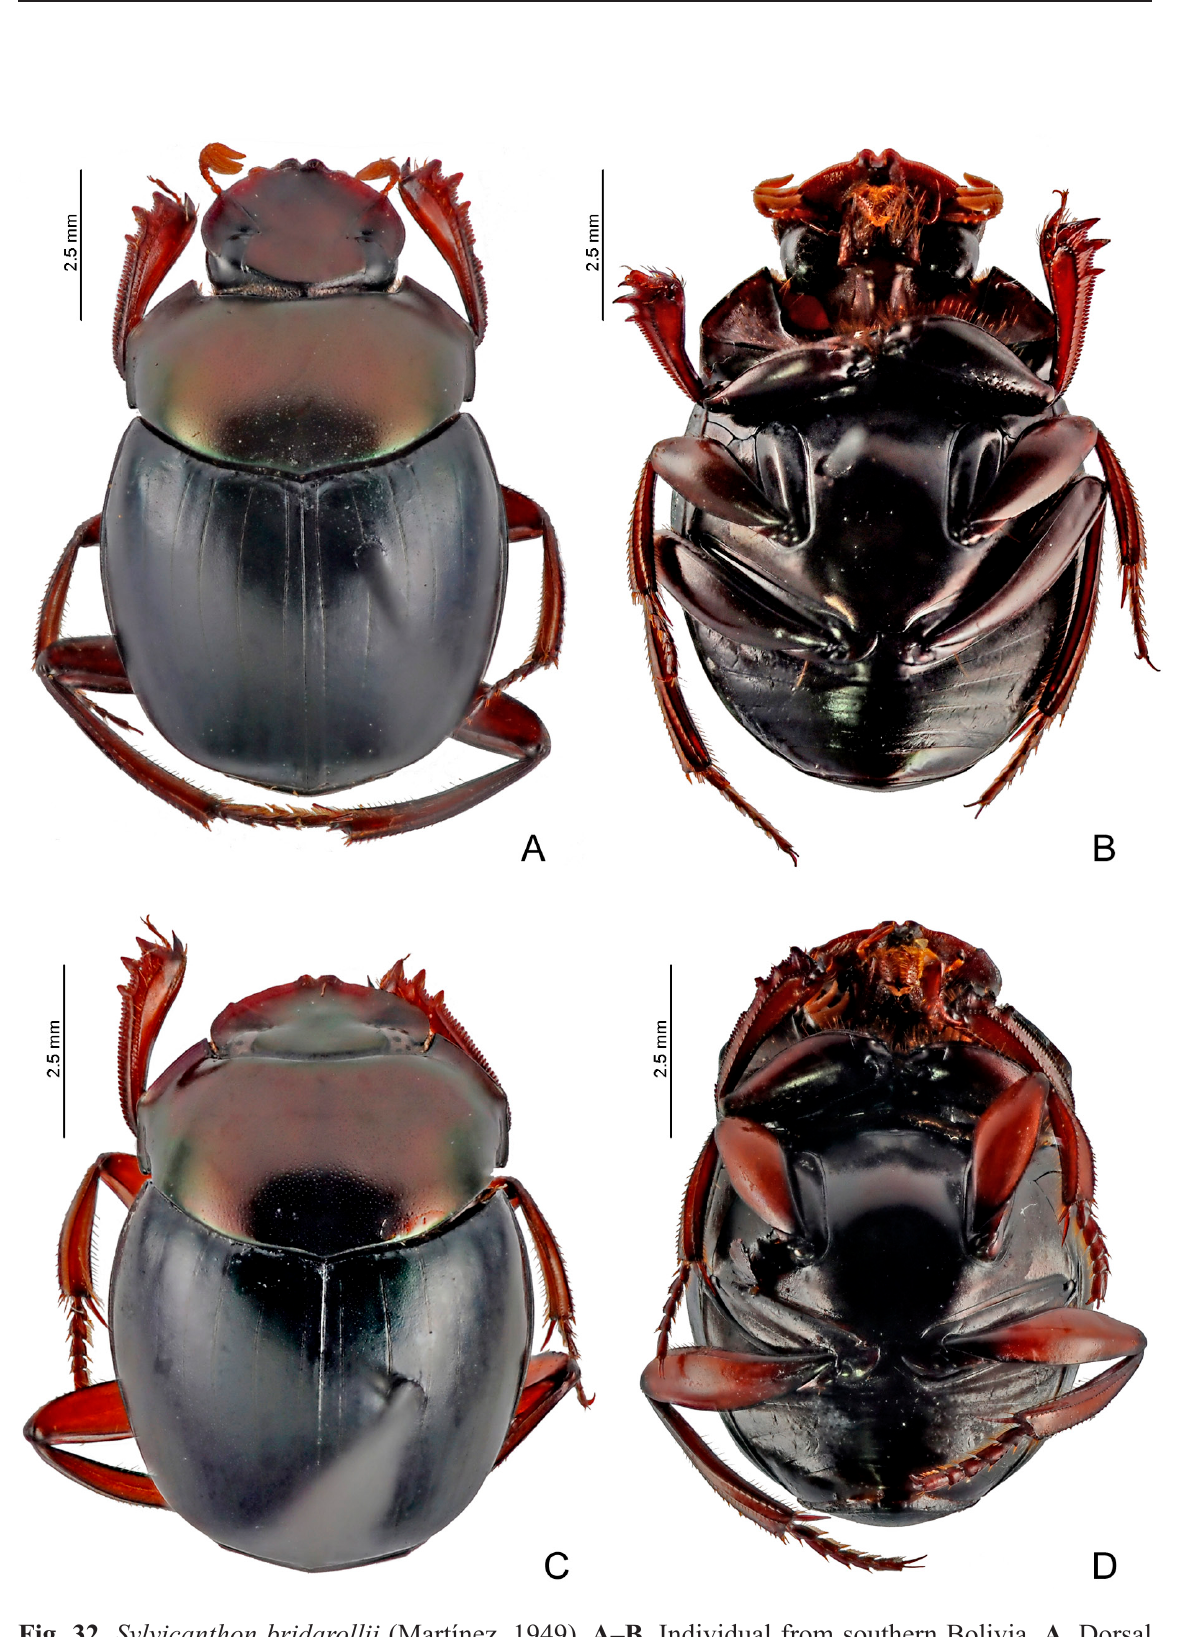
Fig. 32. Sylvicanthon bridarollii (Martínez, 1949). A–B . Individual from southern Bolivia. A . Dorsal view. B . Ventral view. C–D . Individual from Ecuador. C . Dorsal view. D .